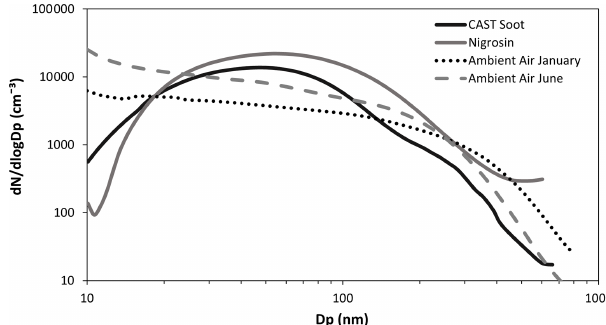
Figure 4. Particle number size distributions of the aerosol sources used in the